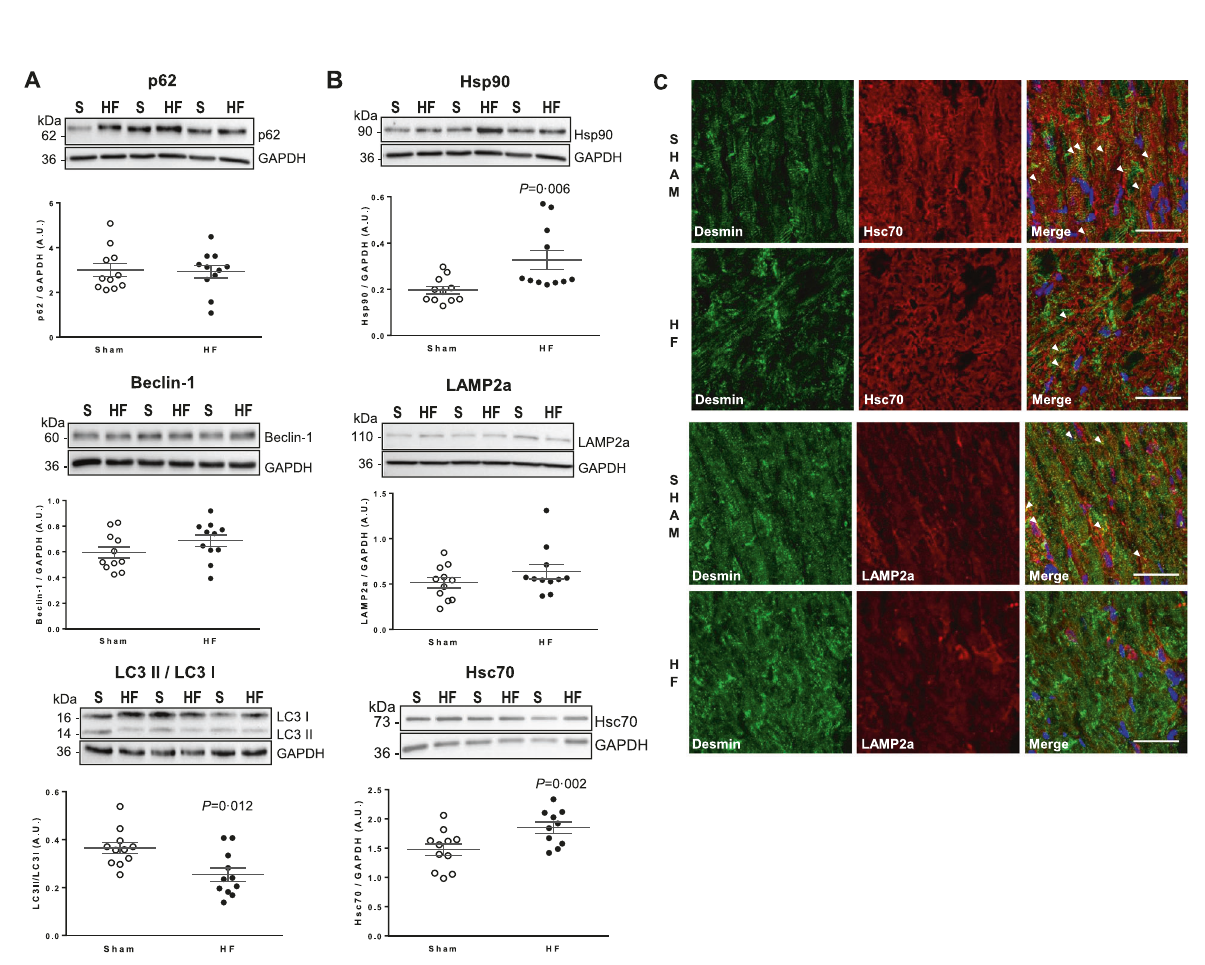
Fig. 2 LV autophagy response to HF following MI. A Representative western blots and quanti fi cation of macroautophagy markers, p62 (top panel), beclin-1 (middle panel), and LC3 II/LC3 I ratio (bottom panel) in LV of sham- ( n = 11) and HF-rats 2 months post-MI ( n = 11). B CMA markers: Hsp90 (top panel), LAMP2a (middle panel), and Hsc70 (bottom panel) were quanti fi ed by western blots in the same samples. The loading controls (GAPDH) are indicated on the graphs. Graphs show individual and mean ± SEM values expressed in arbitrary units (A.U.). Signi fi cant P values are indicated on the graphs. C Double immuno fl uorescence staining for desmin (green) with Hsc70 (red) (top panels) and for desmin (green) with LAMP2a (red) (bottom panels) in LV of sham- and HF-rats 2 months post-MI. Nuclei are stained in blue. Arrows indicate the colocalization of desmin with respectively Hsc70 and LAMP2a. Scale bar represents 30